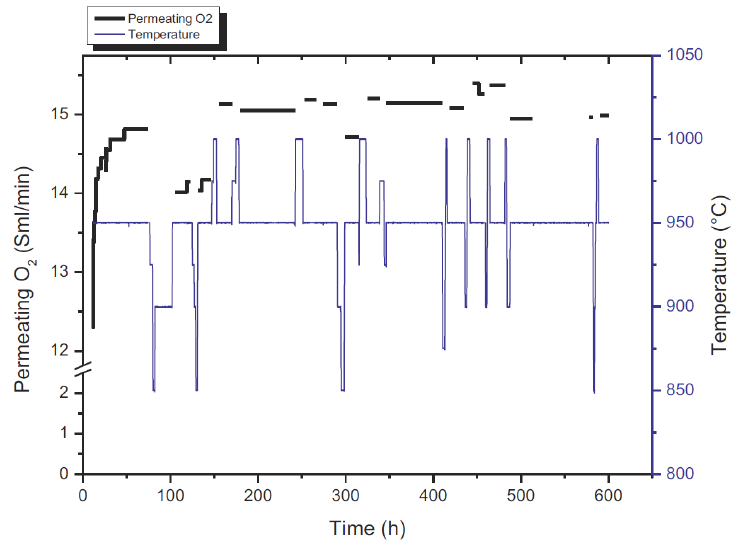
Figure 17. Permeating O 2 flow rate in the outlet of the perovskite membrane reactor with 0.5 mm thickness, permeate side [35]. He flow: 100 mL/min, air flow = 500 mL/min.